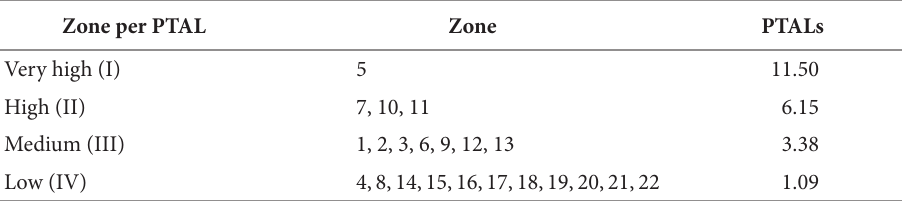
Table 1. Accessibility coefficients per zones of certain